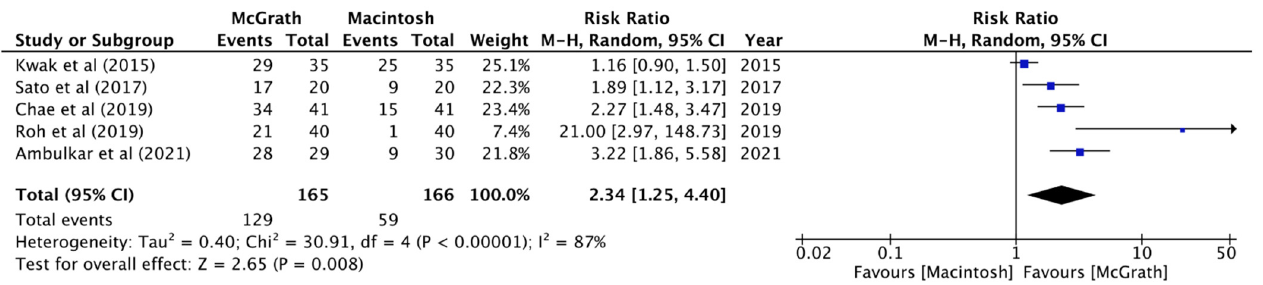
Figure 2. Forest plot of the intubation time of nasotracheal intubation (McGrath vs. Macintosh laryngoscope). The width of the horizontal line represents the 95% confidence interval (CI) of each study, and the square proportional represents the weight of each study. The rhombus represents the pooled rate and 95% CI. (same as below).